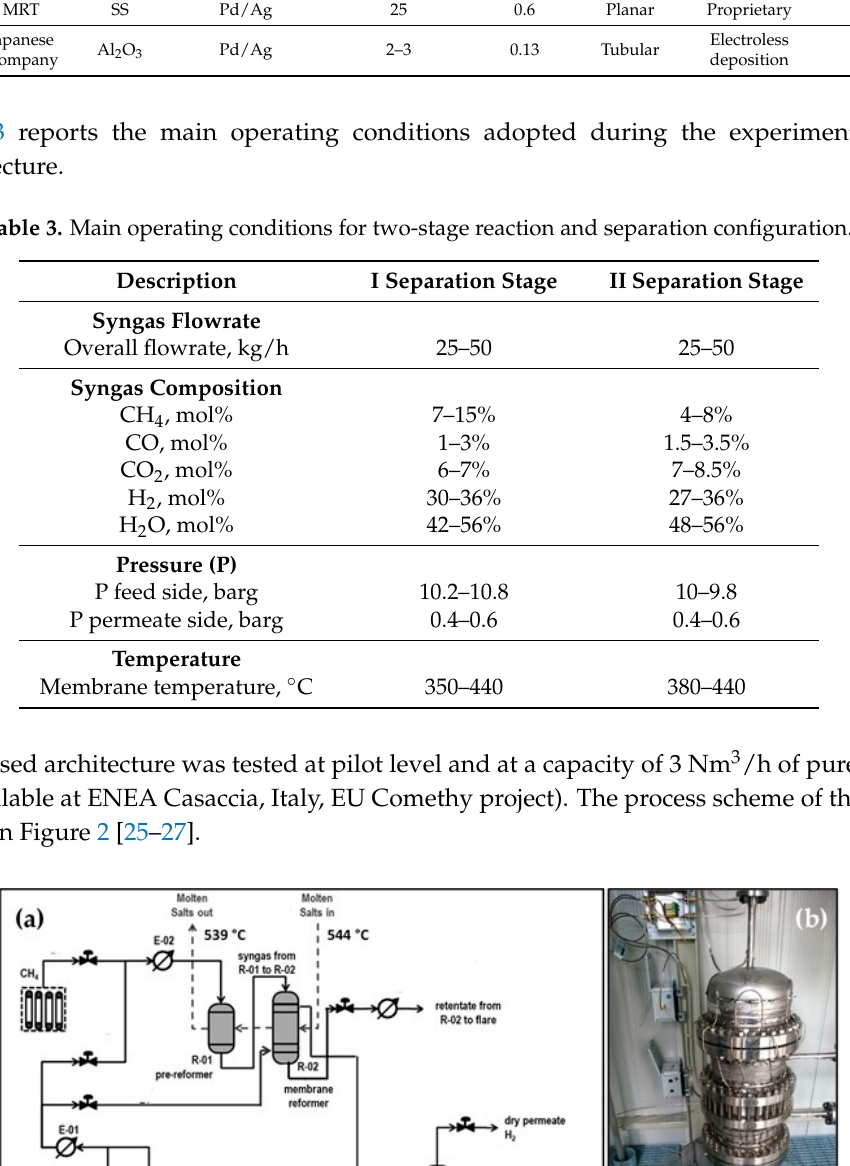
Membrane Supplier Support